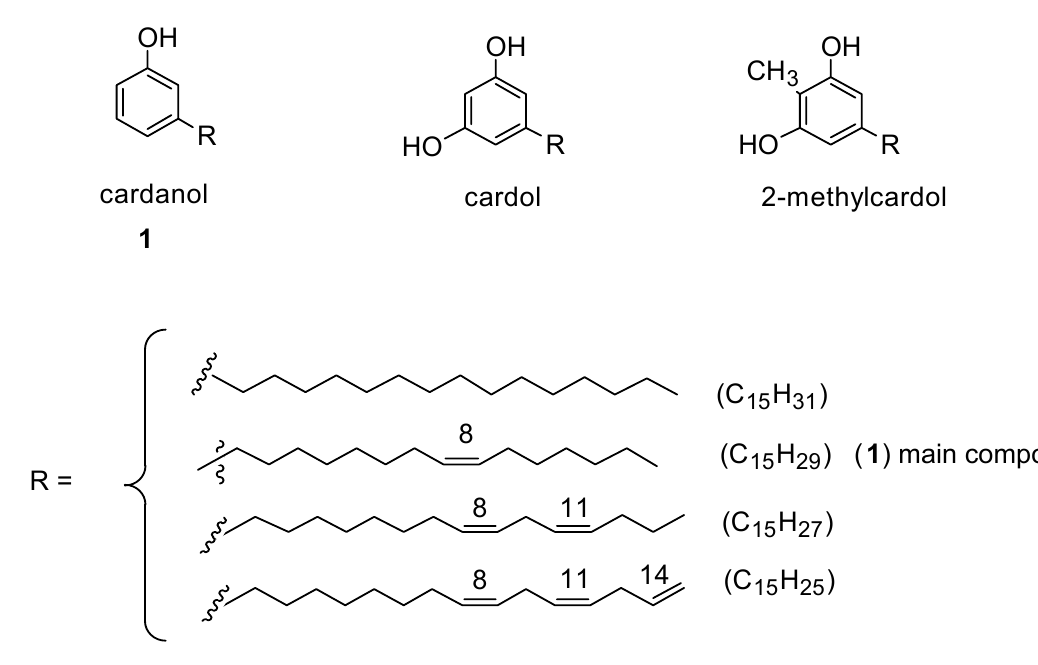
Figure 1. Constituents of technical-grade cashew nut shell